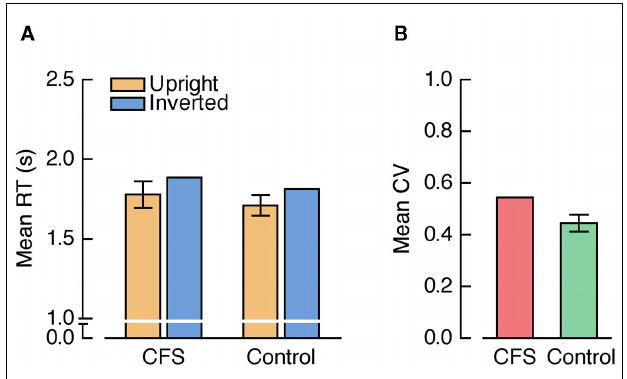
FIGURE 5 | (A) Mean RTs and (B) mean CVs from Experiment